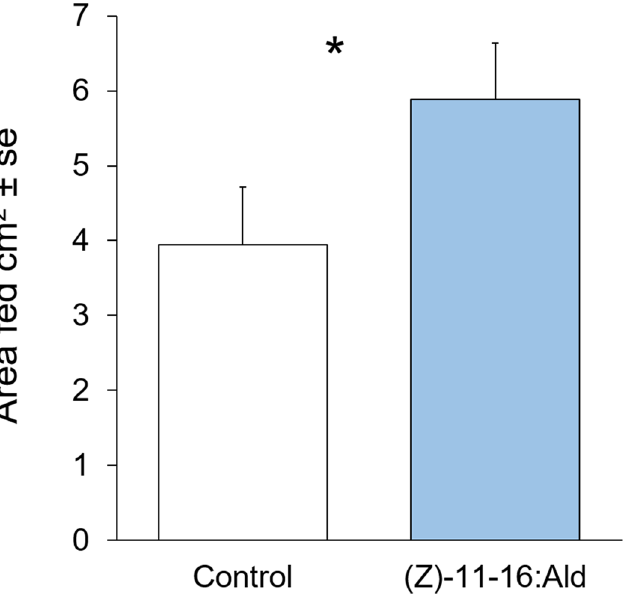
Figure 3. Amount of Brassica nigra leaf consumed by Plutella xylostella larvae in 24 h after exposure of plants to septa loaded with 100 µl of a 100 ppm ( Z )-11-16:Ald solution vapourised over 24 h (n = 10), or non-exposed controls (n = 12). Error bars indicate SE, * P <